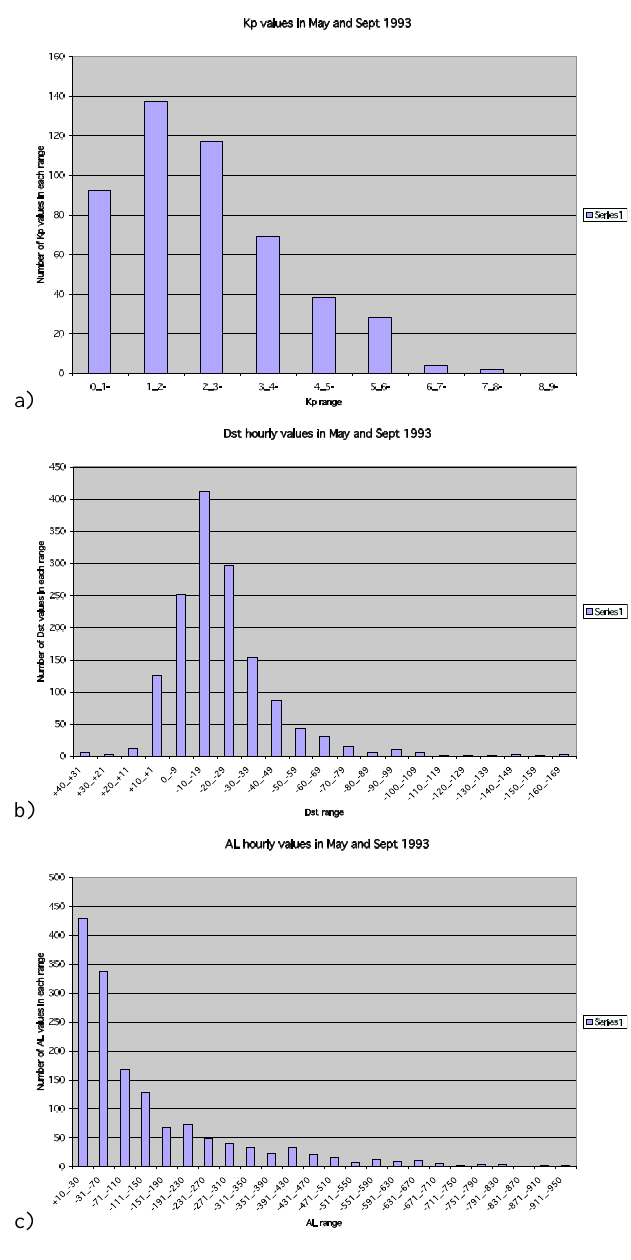
Fig.27. Numbers of ion precipitation events as functions of various indices of magnetospheric disturbance level (a) as a function of K p ; (a) as a function of Dst ; (b) as a function of AL .